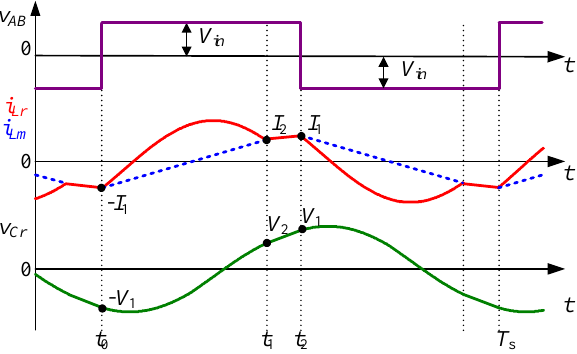
Figure 12. Waveforms of LLC resonant converter below resonant frequency in the ideal case.